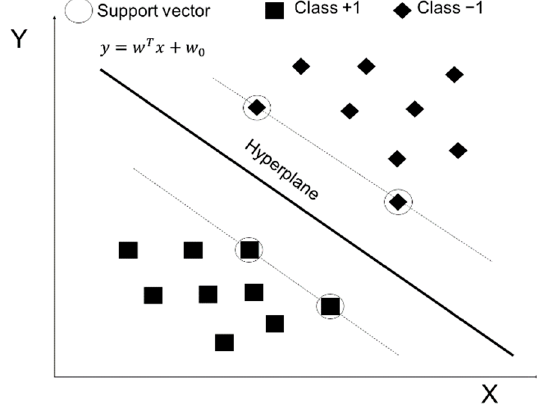
Figure 3. Schematic of the support vector machine. The two data clusters were classified using a hyperplane (defined in Equation (3)) formed in the middle of the outer line of one cluster and the adjacent outer line of another cluster. The distance between the hyperplane and datum close to the hyperplane in the outer line of the cluster (named “margin”) was calculated for each cluster. The margin with the maximum distance was obtained to increase the accuracy of the classification of the support vector machine. The two clusters can be classified as +1 and − 1 by using Equation (4).